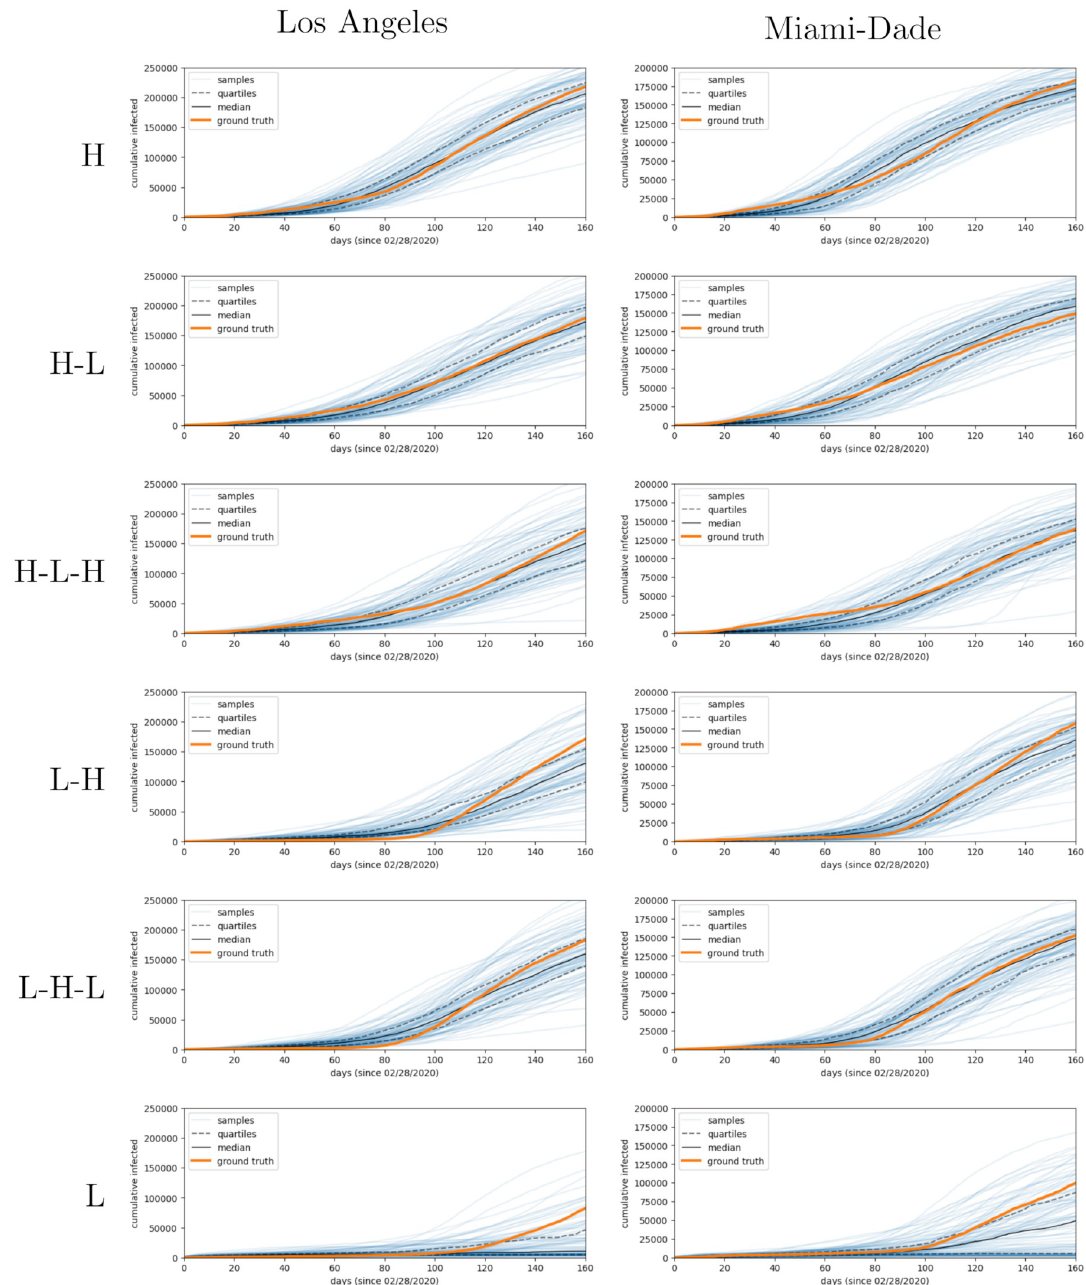
Fig 2. Sampled infection trajectories after fitting parameters on synthetic data. We generate simulated data on Los Angeles and Miami-Dade topologies using known disease parameters, and use this data for parameter inference. Generated disease trajectories use “high”, “high-low”, “high-low-high”, “low-high”, “low-high-low”, “low” patterns, where data is simulated with β E that varies temporally between “high” ( β E = 0.45) and “low” ( β E = 0.1) states.